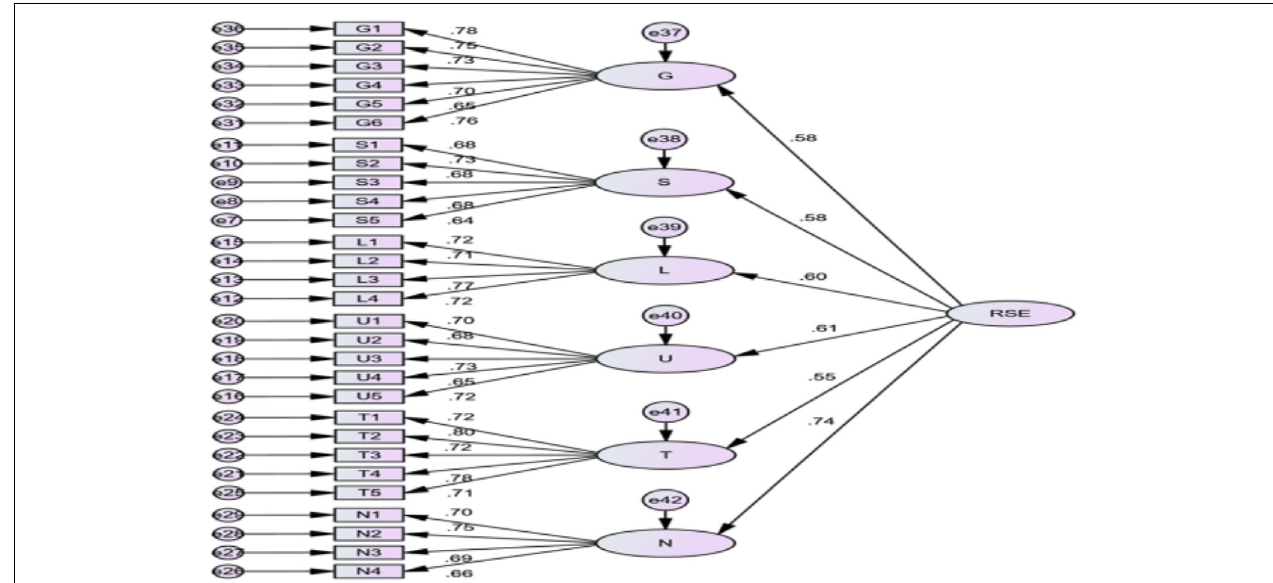
FIGURE 3 | Second-order model of regional soft environment measurement.